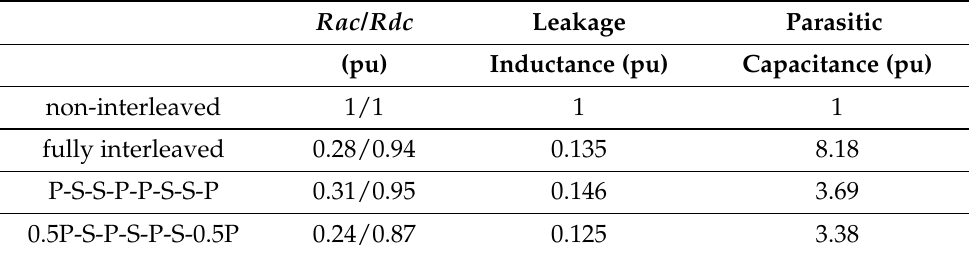
Table 1. Comparison of AC to DC resistance, leakage inductance, and parasitic inductance of non- interleaved and three different interleaving structures. The results are normalized based on the non-interleaved configuration.